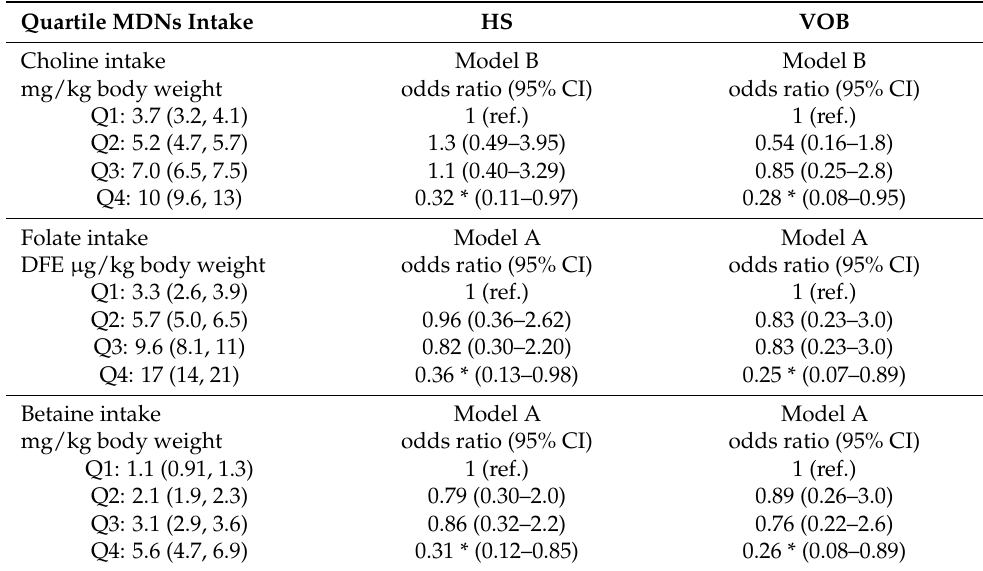
Table 3. Quartile intake of individual MDN associated with HS and VOB 1,2 . Quartile MDNs